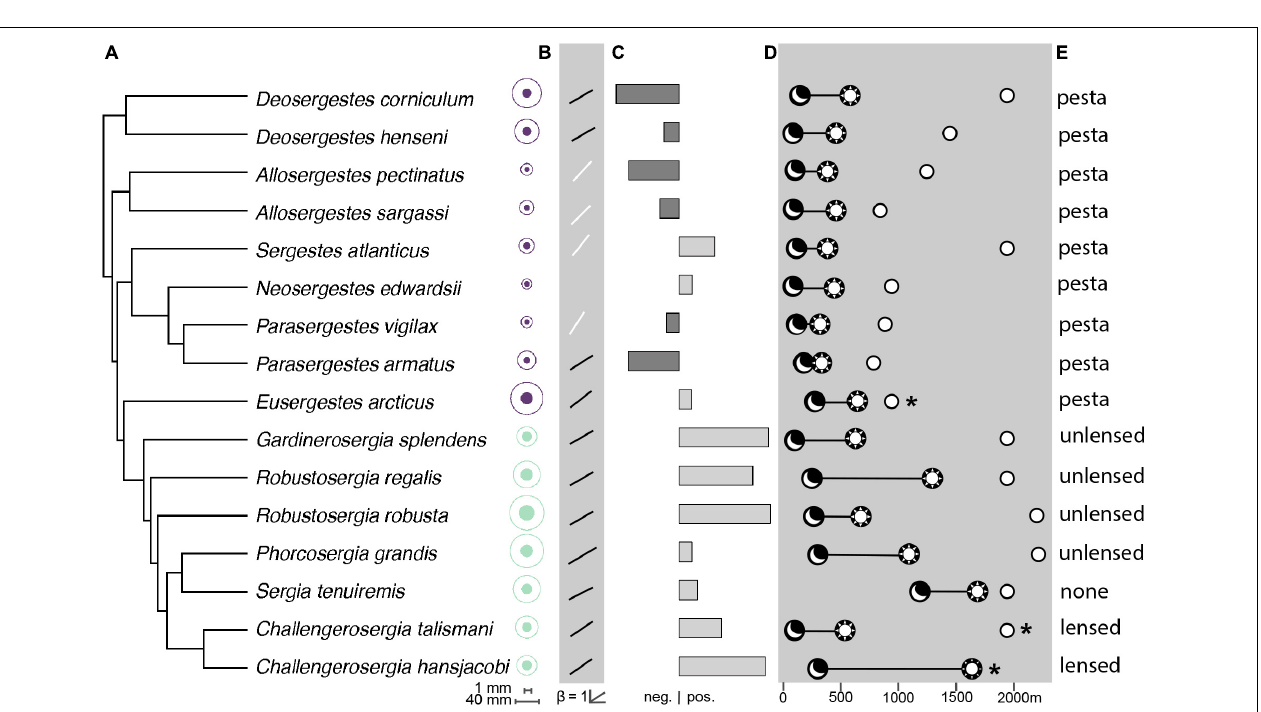
FIGURE 3 | A summary of sergestid eye-size ecology. Data are presented for - sergia (green) and -sergestes (purple) groups of sergestid shrimps across a phylogeny adapted from Golightly et al. (2022). (A) Mean eye size (filled circle) and body size (open circle). The legend indicates how the eye diameter (top) and body length (bottom) scale in absolute terms. (B) Allometric slopes ( β ) from adult eye-body size standardized major axis (SMA) regressions of log 10 eye diameter vs. log 10 body length. White lines indicate allometric slopes that are significantly different from 1 (non-isometric). (C) Residuals from the PGLS regression of sergestid evolutionary eye-body allometry (at λ 1 ) indicates a measure of eye investment, with negative and positive residuals indicating how small or large an eye is for a given sergestid body size compared to what is predicted by the model. (D) Mean depth distributions and (E) light organ types. The moon symbol indicates mean nighttime depth, the sun symbol indicates mean daytime depth, the diel vertical migration (DVM) distance is shown by the black line, and the open circle indicates maximum reported depth. The asterisks indicate species that occupy a benthopelagic habitat. Depth estimates were taken from published literature, see Table 1 for citations.